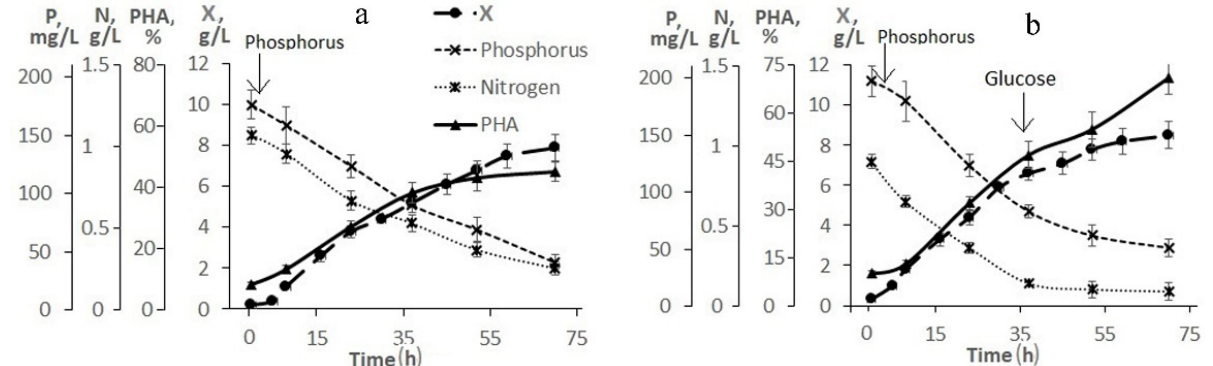
Figure 2. Production parameters of bacterium Cupriavidus necator B-10646 when grown on hydrolyzed sugar beet molasses in 2 L glass flasks under different scenarios of its use: ( a )—20-fold dilution of molasses hydrolysate; ( b )—30-fold dilution of molasses hydrolysate with the addition of phosphorus and glucose to the culture (indicated by arrows).